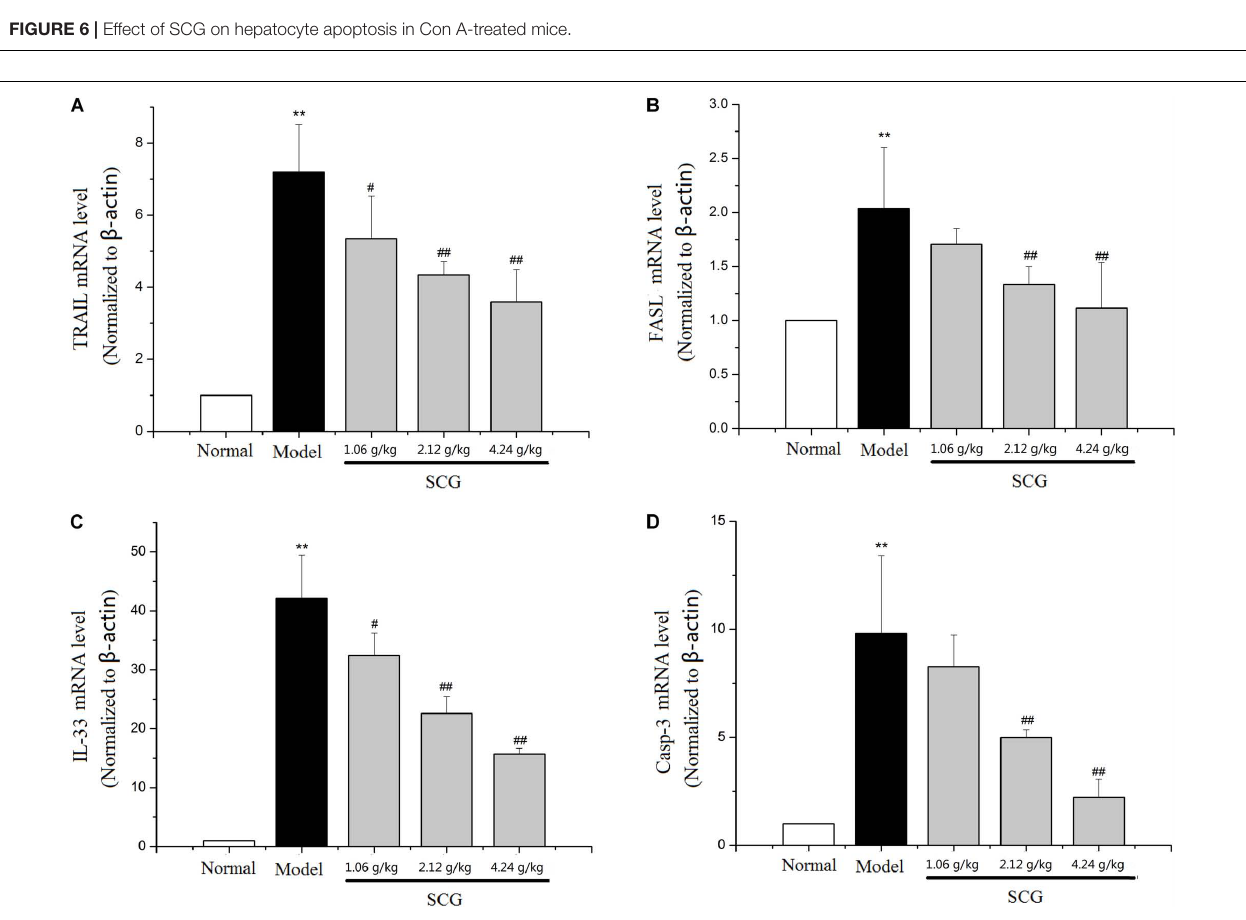
FIGURE 7 | Effect of SCG on mRNA expression of TRAIL, FASL, IL-33, and caspase-3 in Con A-treated mice. (A) The mRNA level of TRAIL. (B) The mRNA level of FASL. (C) The mRNA level of IL-33. (D) The mRNA level of caspase-3. Data were expressed as mean ± SD ( n = 6). ∗∗ P < 0.01 compared with normal group; # P < 0.05, ## P < 0.01 compared with model